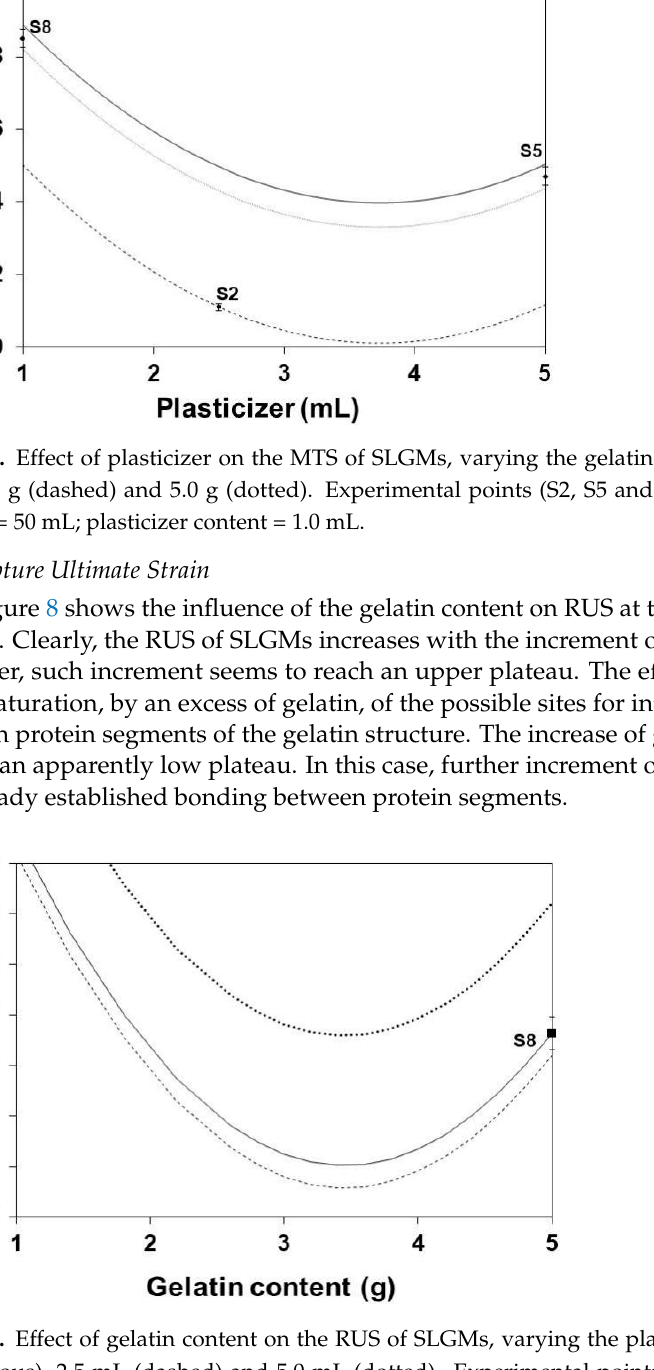
Figure 6. Effect of gelatin on the MTS of SLGMs, varying formation time 1.0 min (continuous), 7.5 min (dashed) and 15.0 min (dotted). Experimental point: S8. Conditions: water content = 50 mL; plasticizer content = 1.0 mL.